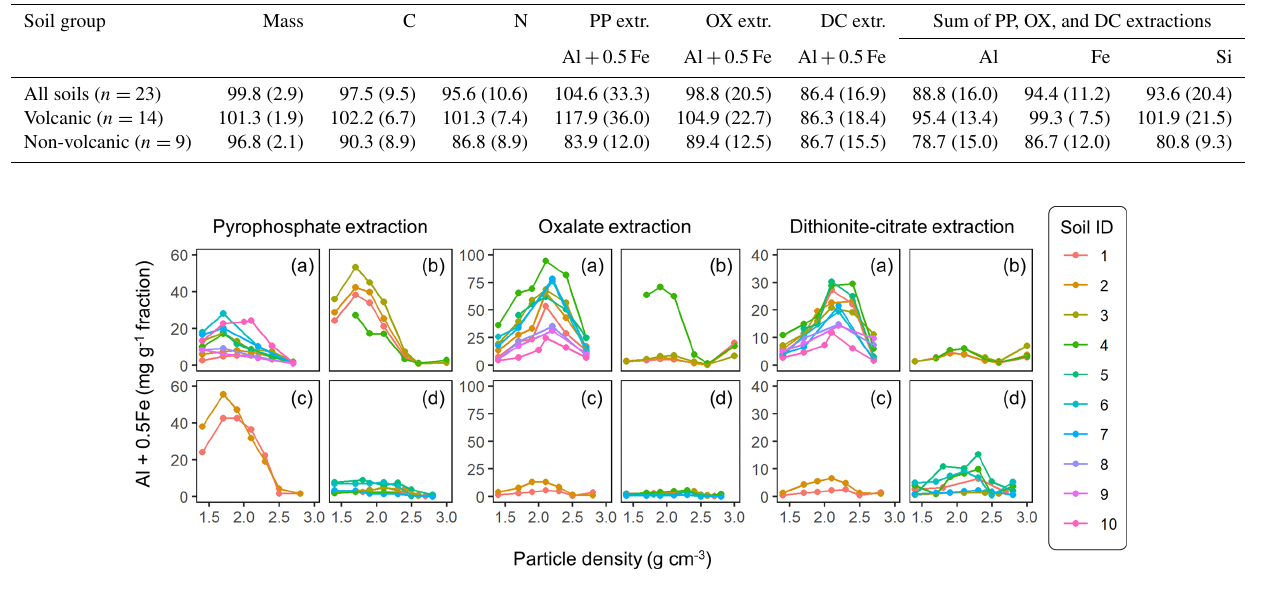
Figure 1. The concentrations of pedogenic metal (Al + 0.5Fe) per fraction along the density gradient for allophanic Andisol group (a) , non-allophanic Andisol group (b) , Spodosol group (c) , and crystalline mineral group (d) . The metal extracted by initial pyrophosphate (left panels), subsequent acid oxalate (central panels), and final dithionite–citrate reagents (right panels) are shown. Each symbol represents an individual soil sample. Sample number (1–10) on the right corresponds to sample ID for each soil group in Table